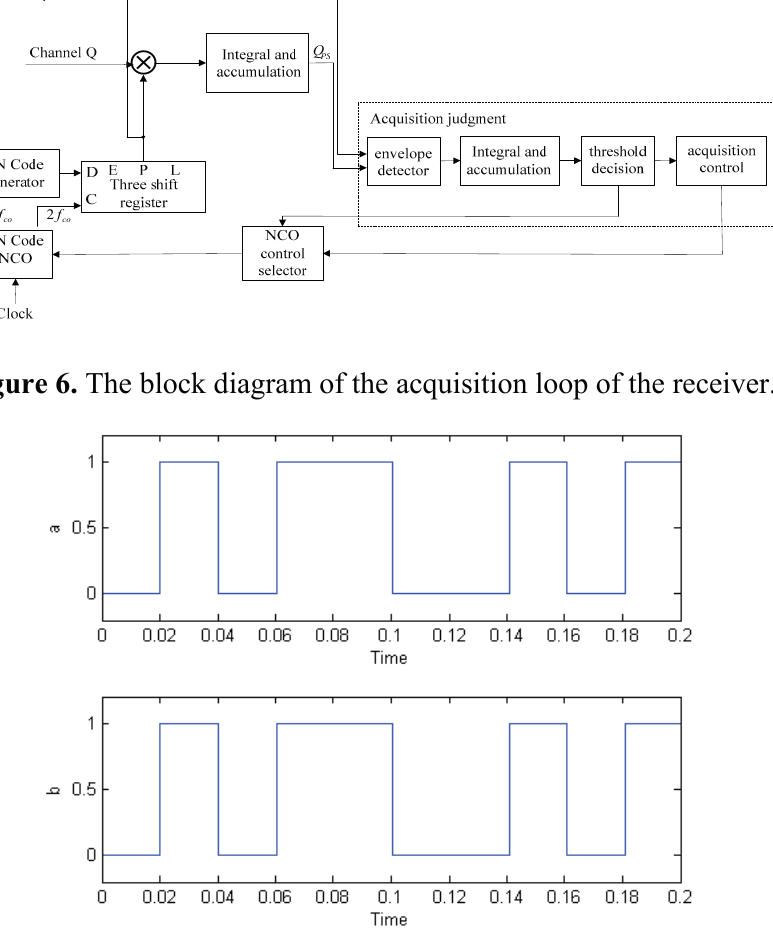
Figure 7. Carrier signal example indicative of the first